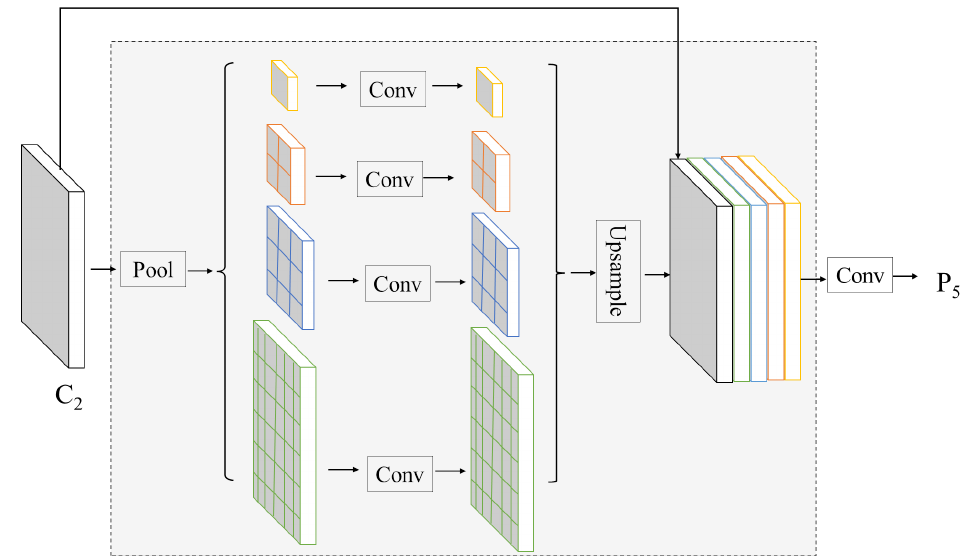
Figure 9. Pyramid pooling